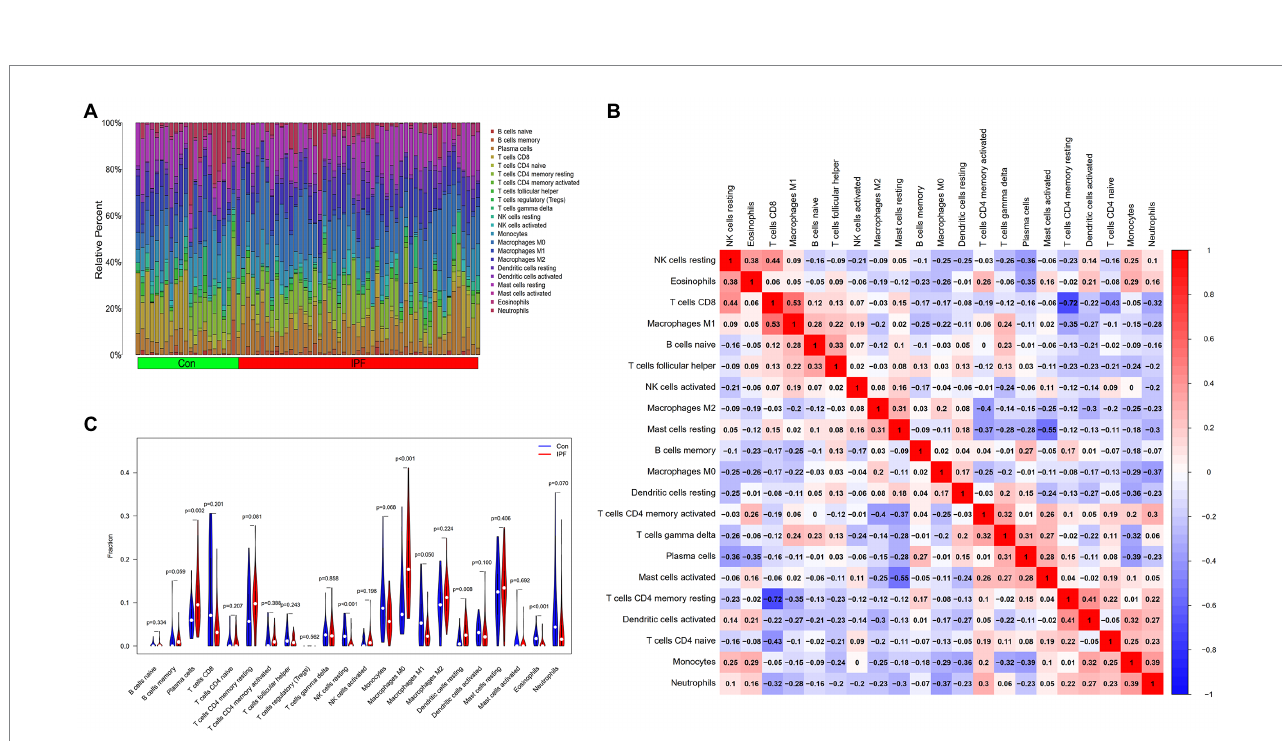
FIGURE 6 Distribution of infiltrating immune cells and the correlation among their infiltration levels. (A) Relative abundance of 22 immune cell subtypes in patients with IPF (IPF) and healthy individuals (Con). (B) Correlation among the infiltration levels of 21 immune cell subtypes (Tregs are not shown); both horizontal and vertical axes demonstrate immune cell subtypes. Red, blue and white represent higher, lower and the same correlation levels, respectively. (C) Comparison of the abundance of 22 immune cell subtypes between patients with IPF and healthy individuals. Blue and red colours represent the infiltration levels of healthy individuals and patients with IPF,